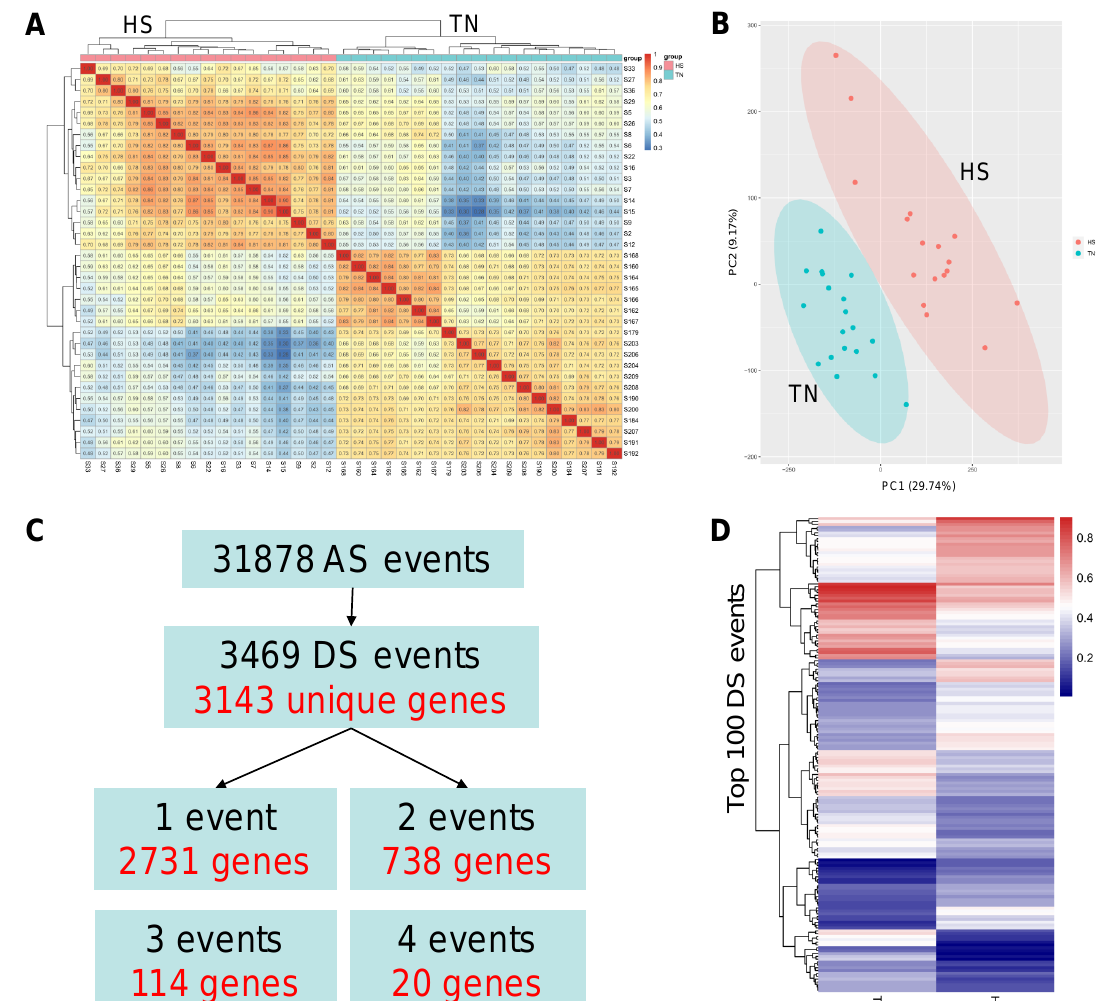
Figure 3. Alternative splicing (AS) profiles and differential splicing (DS) events between the thermal neutrality (TN) and heat stress (HS) groups. ( A ) Pearson correlation analysis of alternative splicing profiles among all samples. ( B ) Principal component analysis of alternative splicing profiles of TN and HS groups. ( C ) Differential splicing events between TN and HS groups. ( D ) Heatmap of the top 100 DS events, colored by percent spliced in (PSI)